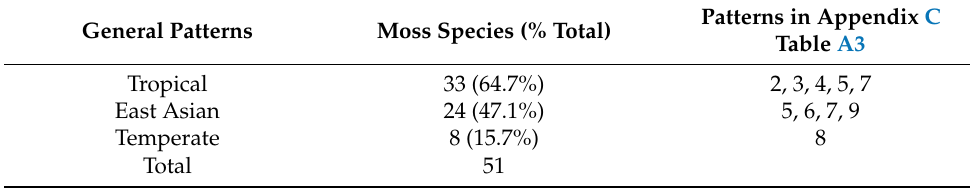
Table 3. General phytogeographical elements of terrestrial moss species on Tai Mo Shan. General Patterns Moss Species (%